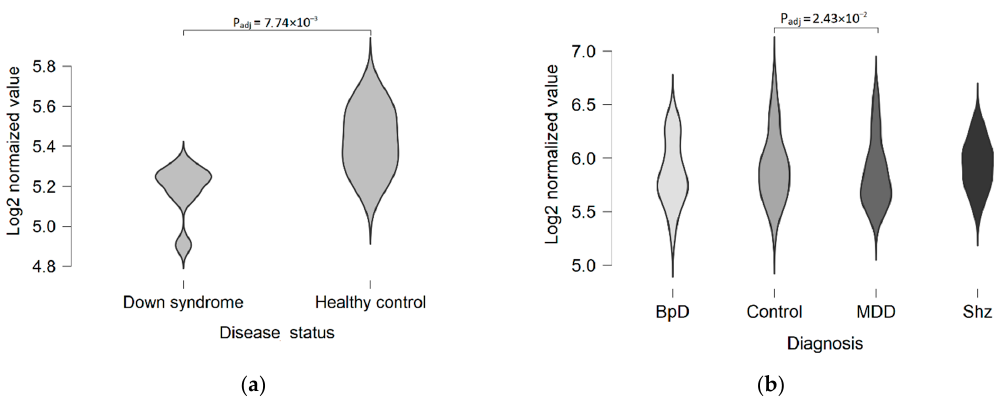
Figure 2. TAAR5 expression in the dorsolateral prefrontal cortex of healthy humans and patients with different neuropsy- chological or psychiatric conditions. ( a ) Downregulation of TAAR5 expression in Down syndrome patients (GSE5390, adult Down syndrome, n = 9, healthy controls, n = 6); ( b ) dysregulation of TAAR5 expression in patients with psychiatric disorders (GSE92538, bipolar disorder, n = 12, major depressive disorder, n = 29, schizophrenic, n = 31, control group, n = 55). BpD—bipolar disorder, MDD—major depressive disorder,